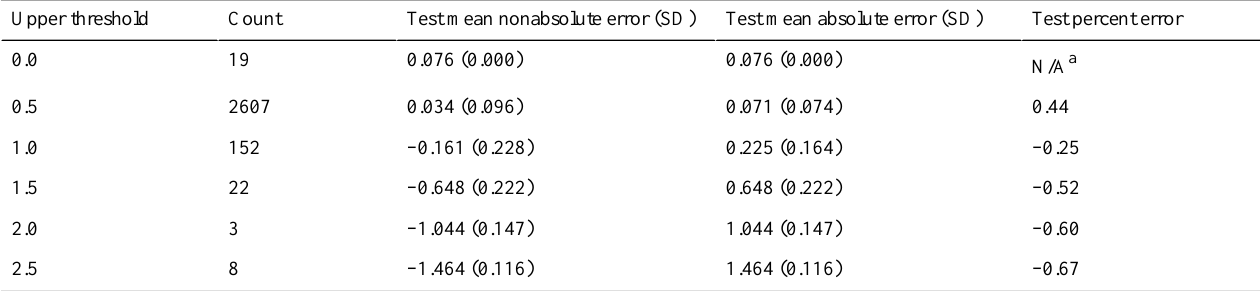
Table 11. Test errors and median percent errors of label bins of size 0.5 for the out-of-distribution validation